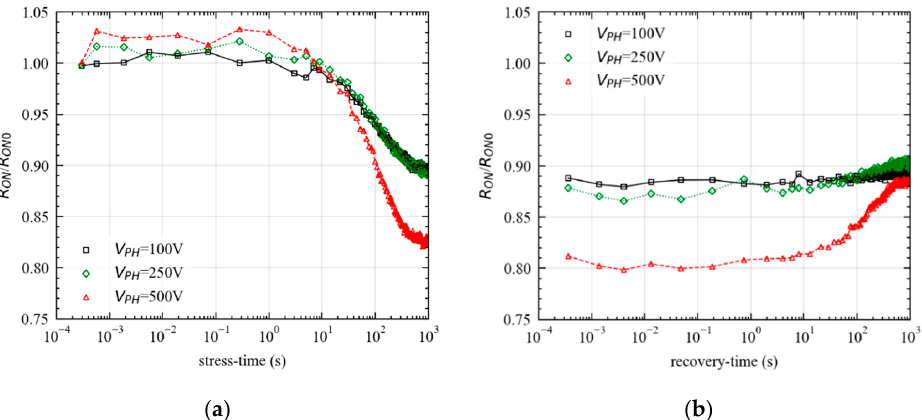
Figure 13. ( a ) Effect of drain off-state stress voltage on the R ON drift during the stress with V GH = 15 V. The R ON drift retained after 1000 s increases for V PH = 500 V. ( b ) Monitored R ON recovery at different drain stress voltages (100 V, 250 V, and 500 V) with V GH = 15 V.